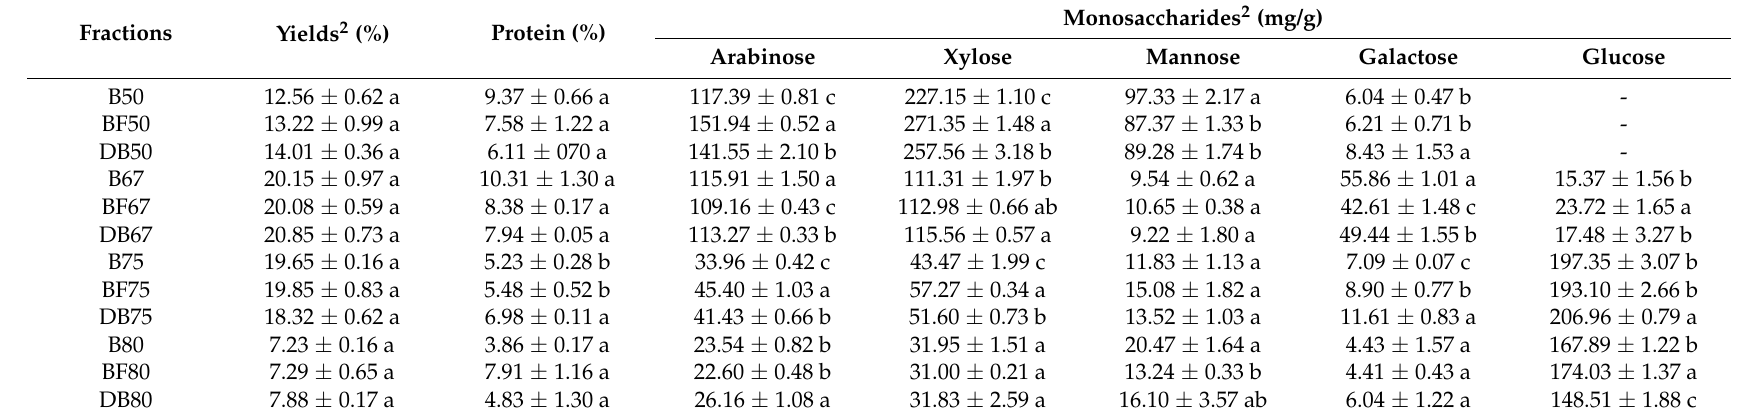
Table 2. Analysis of yields, protein, and monosaccharides in ethanol